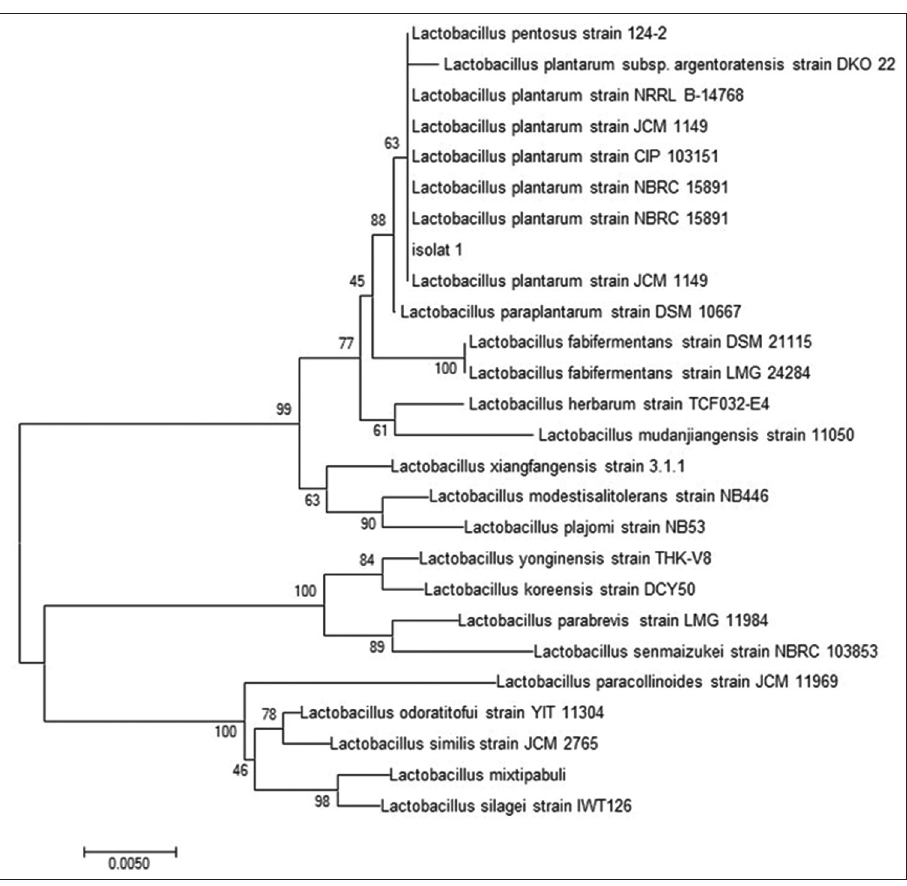
Figure-1: Phylogenetic tree of 16S rRNA gene of Lactobacillus plantarum N5 isolated from fermented buffalo milk ( dadih ) using neighbor-joining method MEGA 7.0.